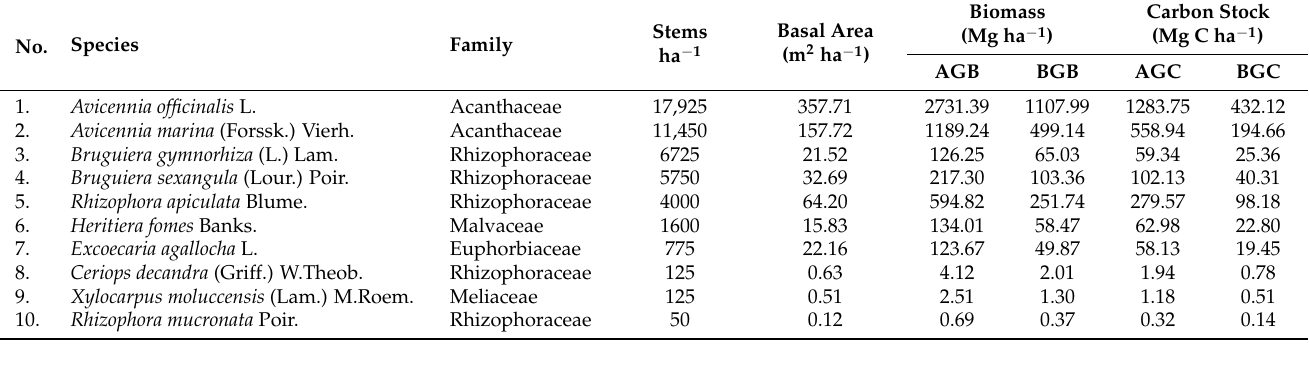
Table 1. Structural composition of the recorded species in the study site.